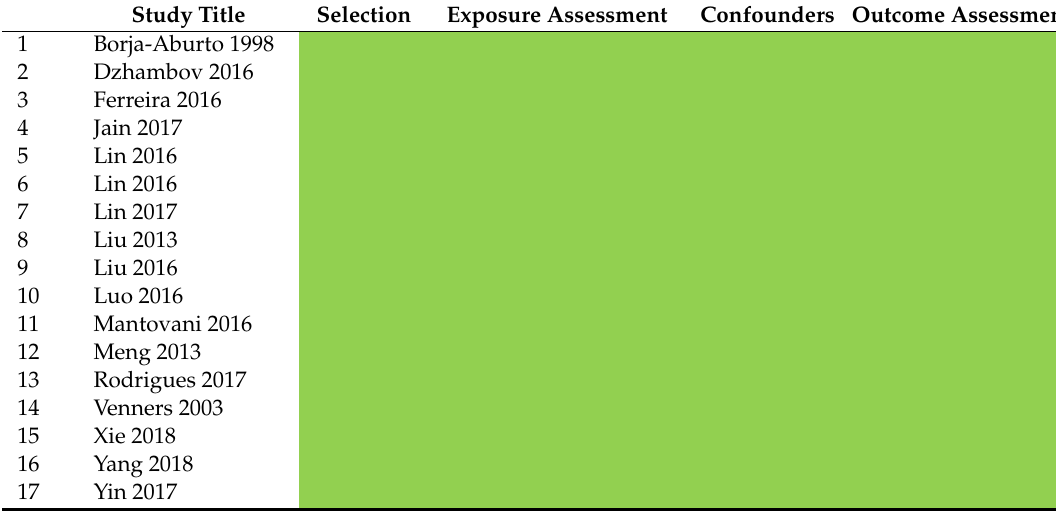
Table A1. Low risk of